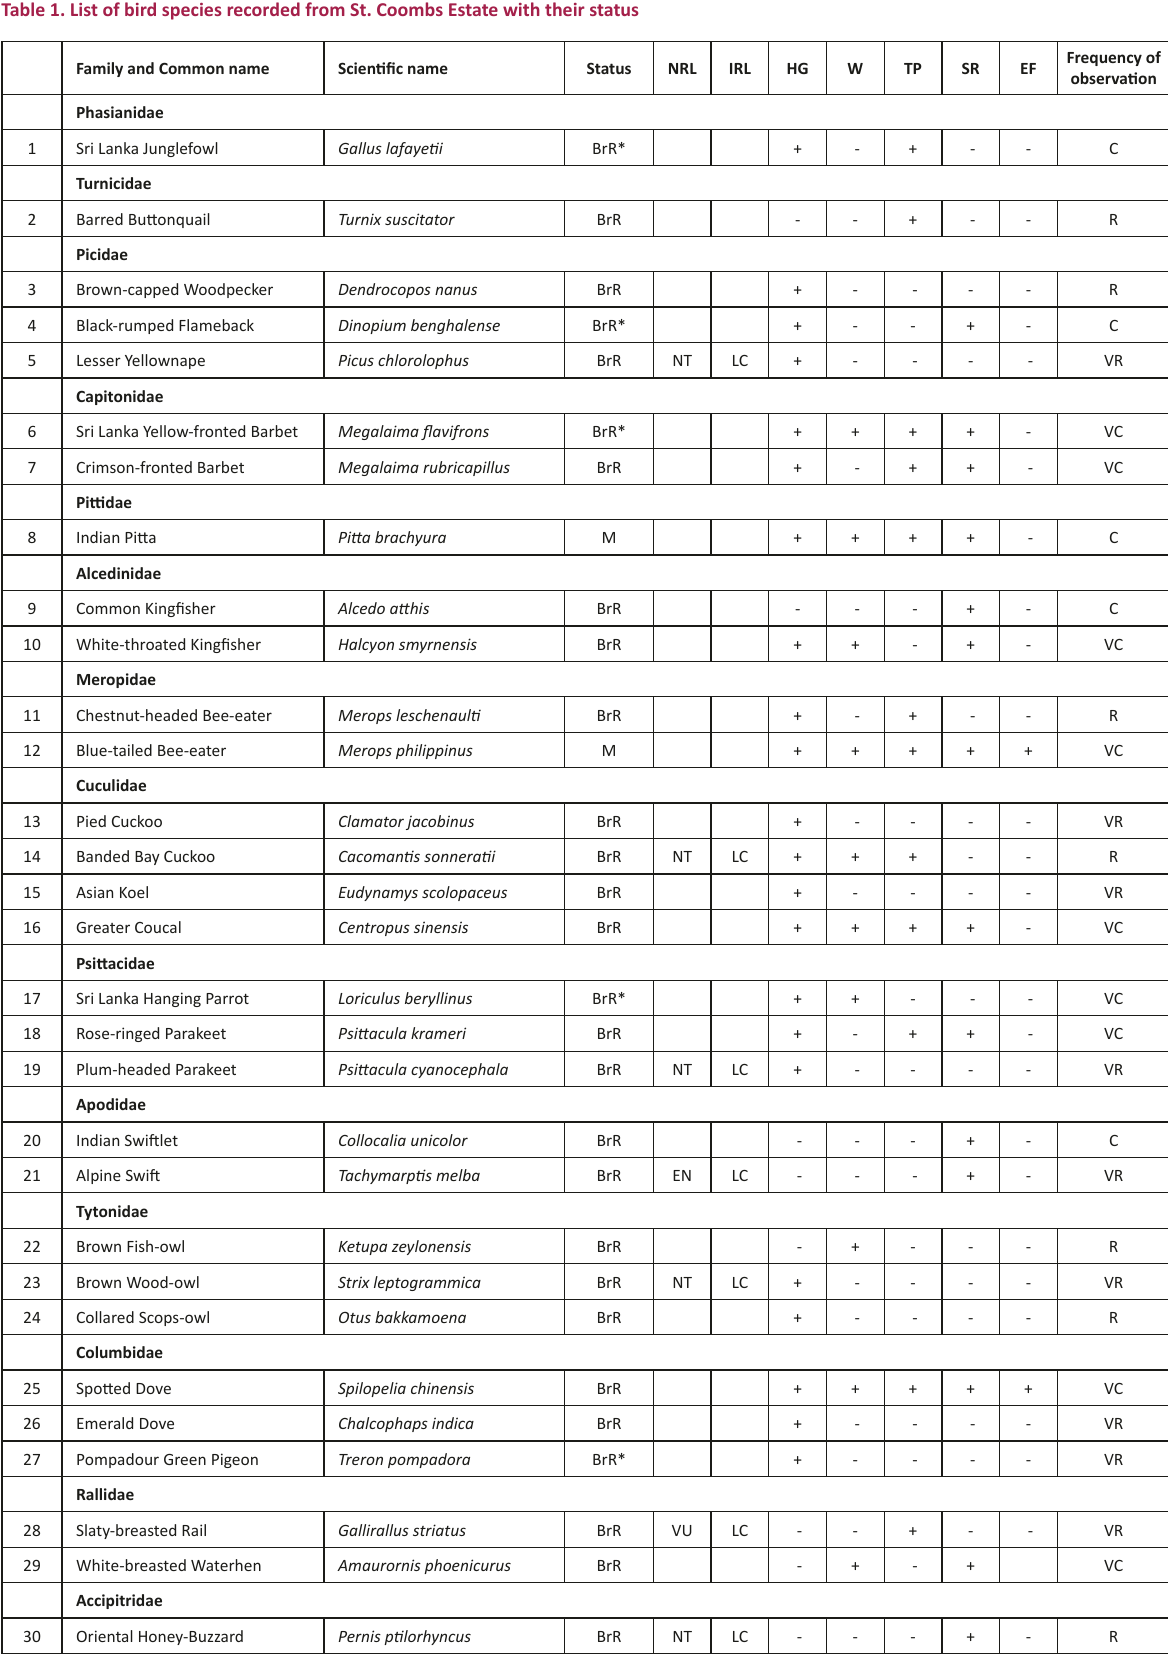
Table 1. List of bird species recorded from St. Coombs Estate with their